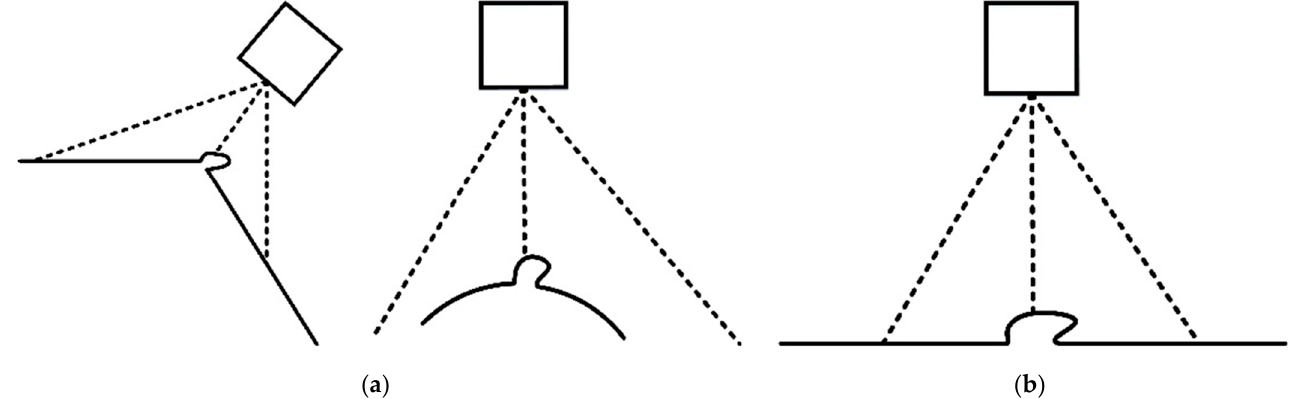
Figure 4. Burr detection system: contour scans of burrs on ( a ) processed edge and ( b ) parting lines/risers.